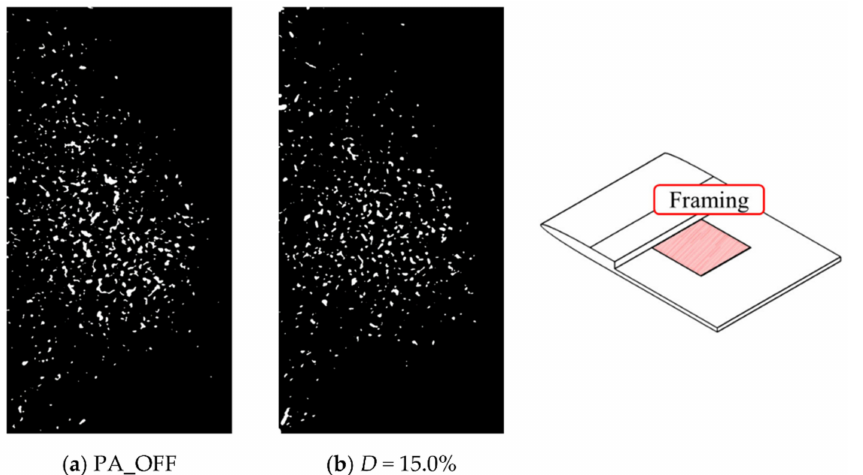
Figure 26. Snow accumulation test (standard model)